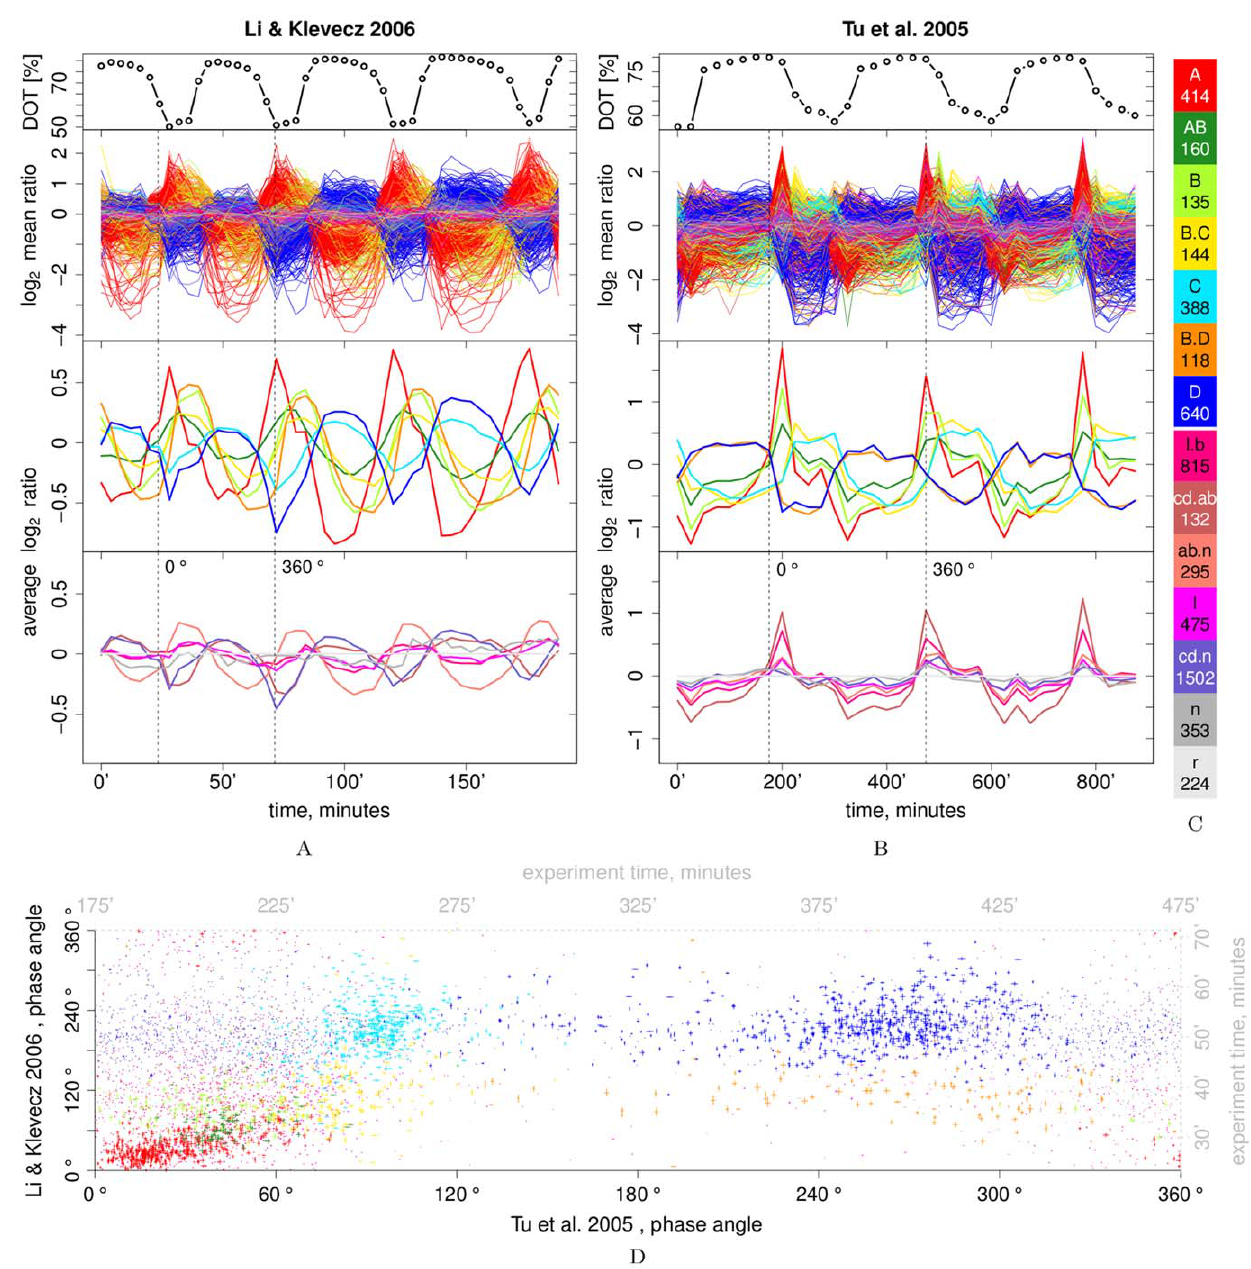
Figure 1. Clustered transcript time course profiles. 0 and 0: overlaid time courses of summarized microarray fluorescence for each yeast gene, as the log 2 of the mean-ratio ( log 2 ( x = (cid:2) xx ) ), for the 0.7 h [11] and 5 h [10] period datasets, respectively. The bottom two panels show cluster averages for consensus and background clusters. The top panel shows the time courses of the dissolved O 2 trace (DOT) in the culture medium in percent of the saturated concentration. Cluster colors and sizes (number of genes in each cluster) are given in the legend in Figure 1C. For clarity of visualization the time course data was normalized to a reference set that was selected for significant lack of oscillation (see Text S1 for fundamental problems with normalization of these datasets). Individual time courses for each cluster are plotted in Figure S2. 1D: phase-phase plot comparing the phase-angles of all transcripts in the two experiments. The phase angles were shifted such that cluster A phase angles are just above 0 u in both datasets. w k c Mapping back from frequency- to time-domain, we can locate the shifted phase angles of one cycle (0 u and 360 u ) in the time series plot (vertical lines in Figures 1A and 1B), and use the same mapping in the top and right axes (in gray) of the phase-phase plot. The x- and y-extensions of each point in the respective dataset, where the non-consensus clusters (lower case letters) have a smaller initial scale with the transcript’s scaled amplitude a k c size. Dataset S1 provides raw summarized microarray intensities, and the clustering of all analyzed yeast genes. doi:10.1371/journal.pone.0037906.g001 could be assigned to low-amplitude clusters l.b (815 genes, similar to the microarray (r). Transcript abundance of cluster A genes peaks cluster B) and cd.n (1,502, similar to cluster C/D), to noisy and/or when respiratory activity is maximal (0.7 h) or accelerating (5 h). non-consensus time series (cd.ab, ab.n, l, n) or were not present on The more frequently sampled dataset from the 0.7 h period (sample